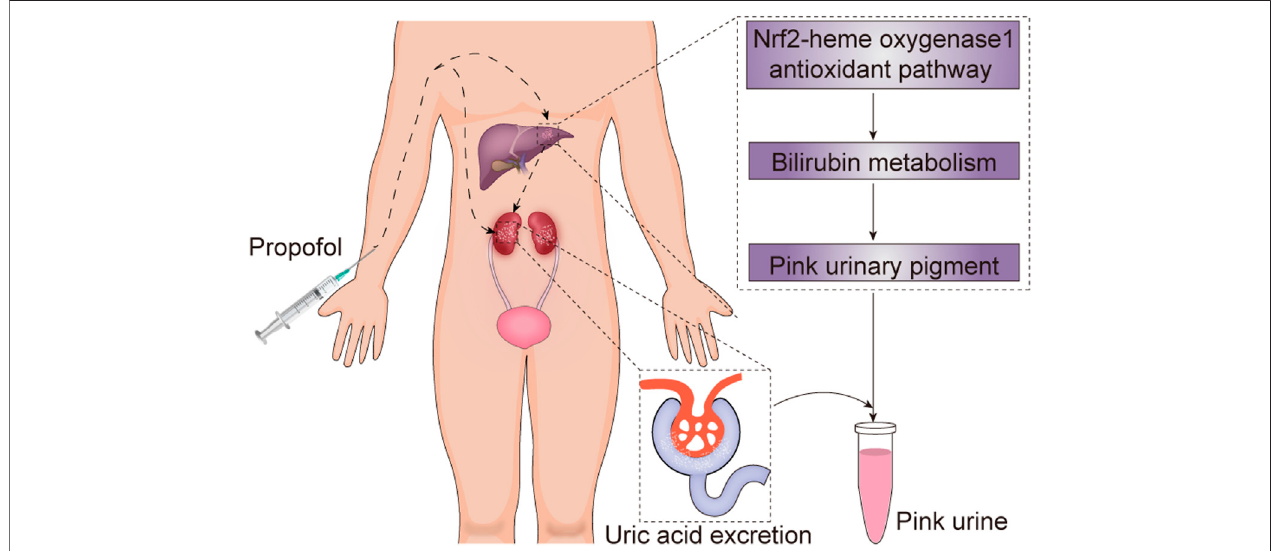
FIGURE 4 | The potential mechanism underlying propofol-induced pink urine syndrome. Propofol can directly increase colorless uric acid excretion and promote pink urinary pigment production through bilirubin metabolism by activating the Nrf2-heme oxygenase-1 antioxidant pathway, and consequently result in pink urine